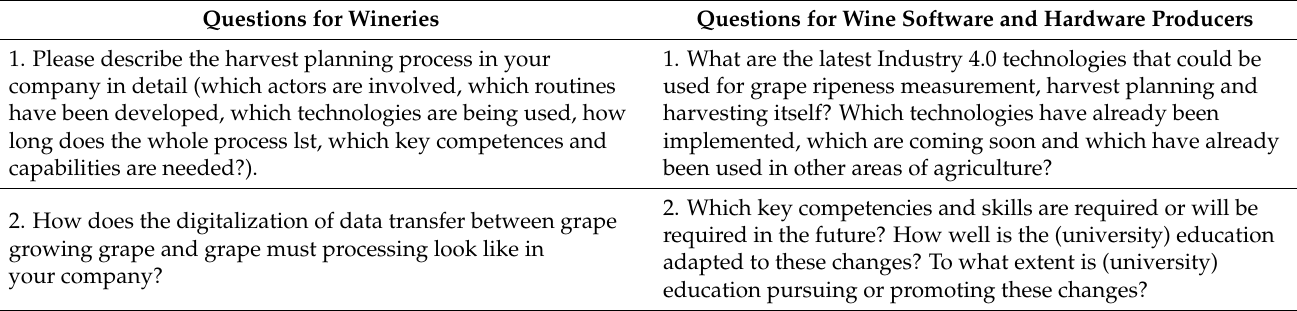
Table A3. Questionnaire with open-ended questions used to conduct semi-structured interviews with SMEs on the left and software and hardware producers on the